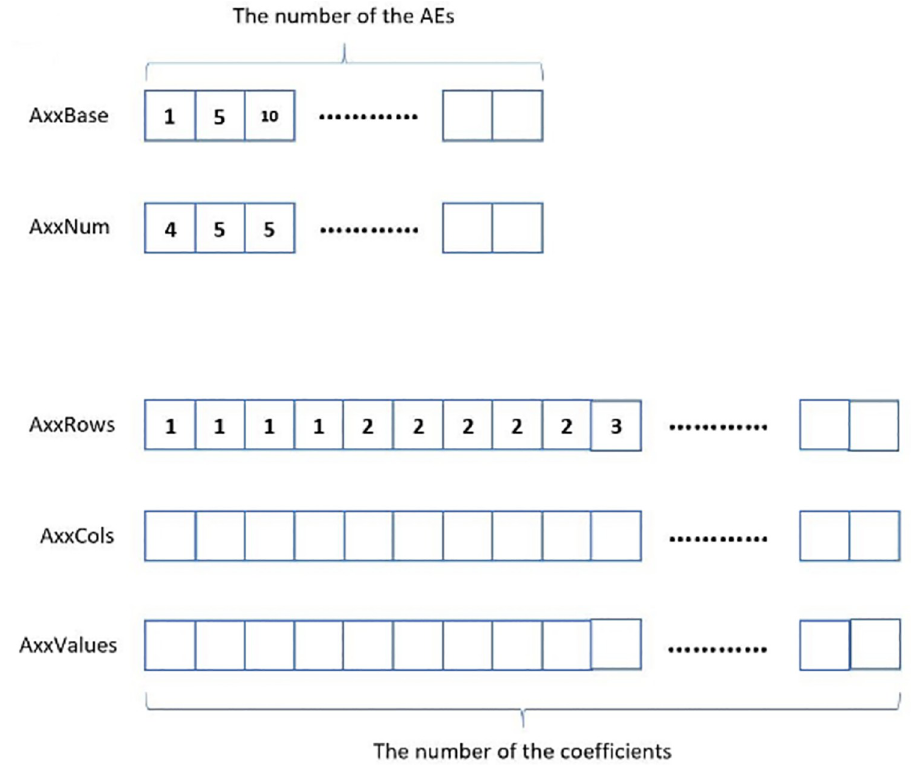
Fig 5. The five arrays help store the coefficients of u x in Eq (2).